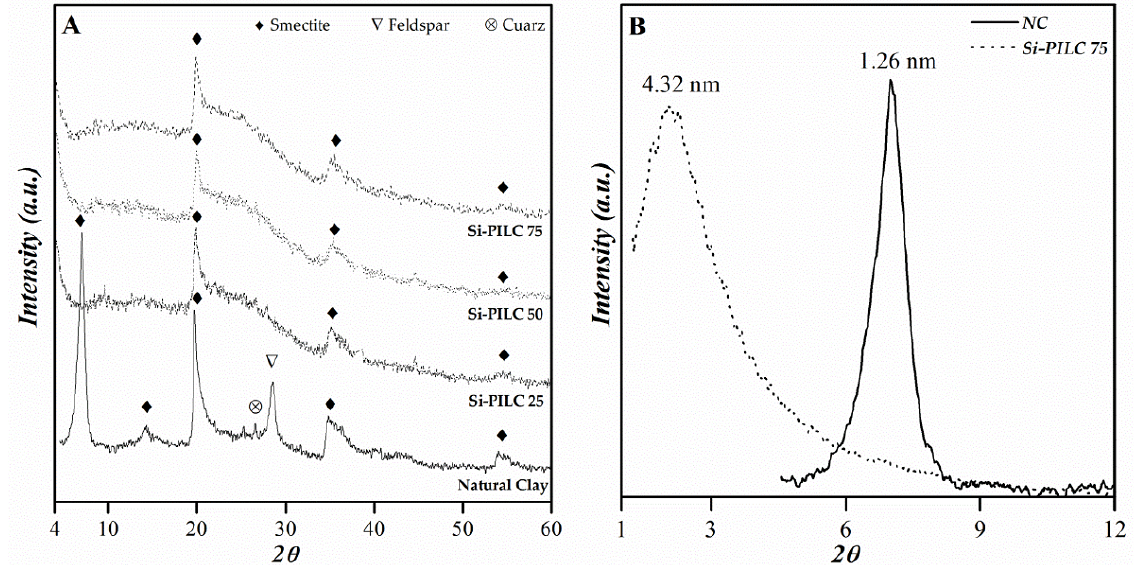
Figure 1. XRD patterns of NC and Si-PILC. (XRD: X-Ray